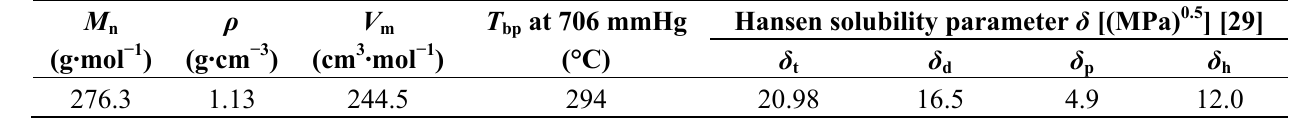
Table 1. Typical properties of triethyl citrate